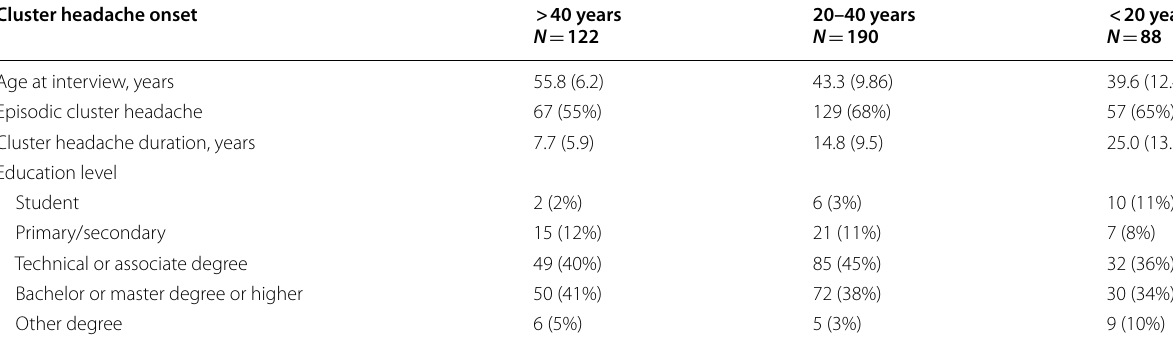
Data presented for 400 patients as means (SD) for numerical variables and as number (percentages) for categorical variables. The table implies that educational attainment was slightly higher in age of onset above 20 years old. However, the mean age was lower in the group with age of onset before the age of 20 and more people were students. The group only completing primary or secondary level is smallest in the group with onset before the age of